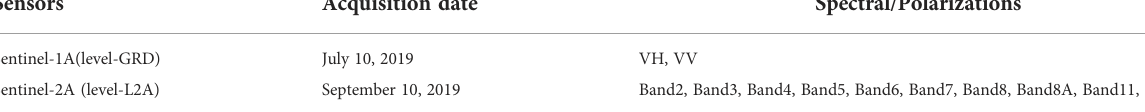
TABLE 2 The information of acquired remote sensing